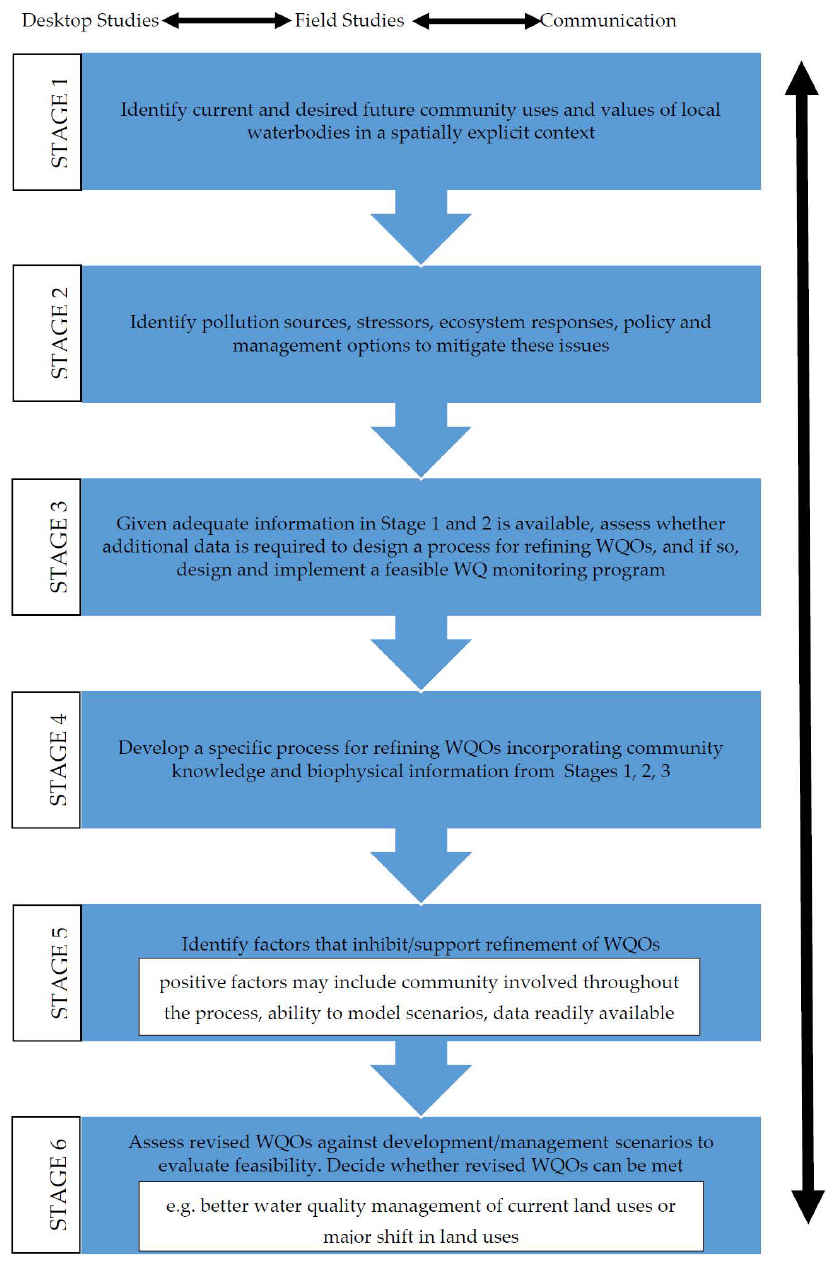
Figure 2. Conceptual framework for revising freshwater Water Quality Objectives (WQOs) using biophysical and social knowledge (Tsatsaros [18]) * adapted and modified from Bohnet [18,35]. Black arrow on the right shows the process is not unidirectional but may involve iterative processes.